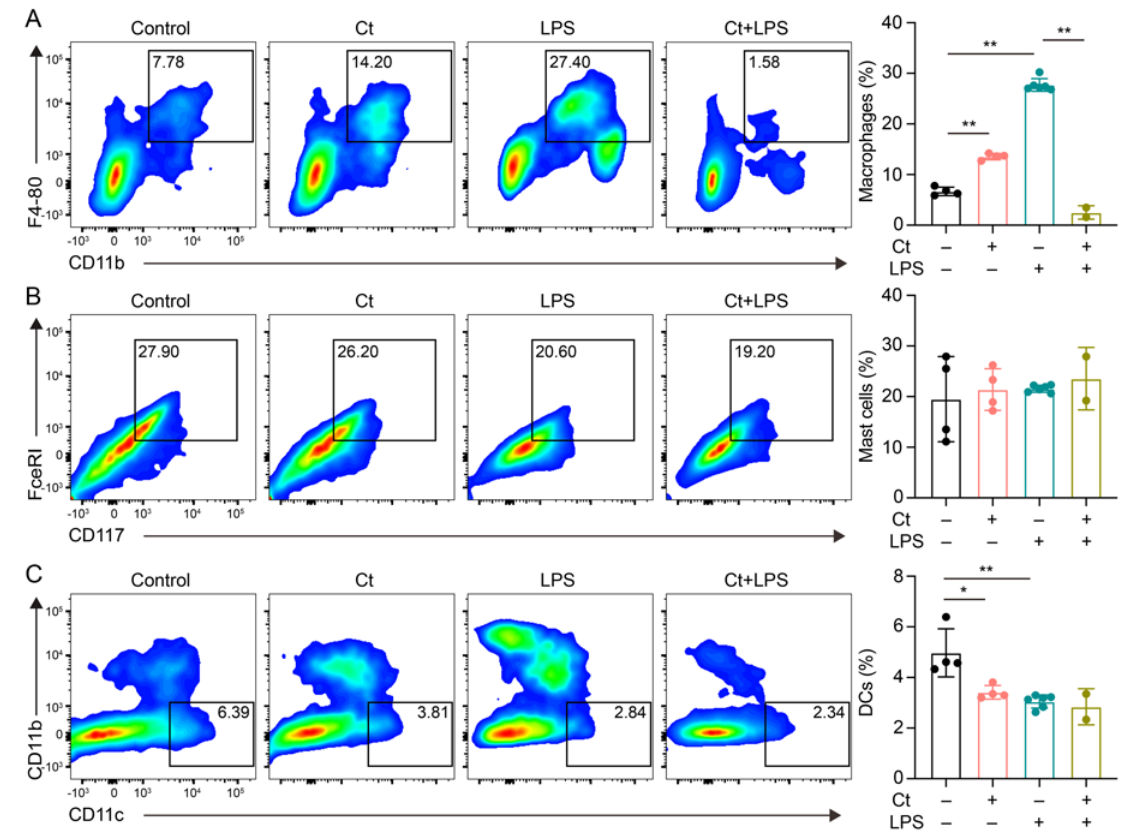
Figure 2. Effects of Ct on proportions of macrophages, mast cells, and dendritic cells (DCs) in mice. ( A ) Proportion of macrophages; ( B ) proportion of mast cells; ( c ) proportion of DCs. Each dot presented one mouse. Data presented as mean ± SEM. * p < 0.05, ** p < 0.01 by two-way unpaired t -tests.